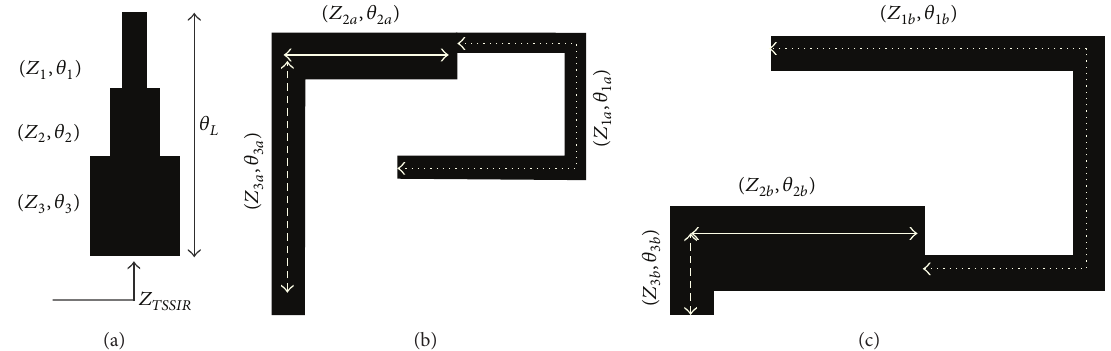
Figure 1: Configurations of (a) general trisection SIR, (b) proposed TSSIR 𝑎 resonating at the first and third center frequencies, and (c) proposed TSSIR 𝑏 resonating at the second center frequency.